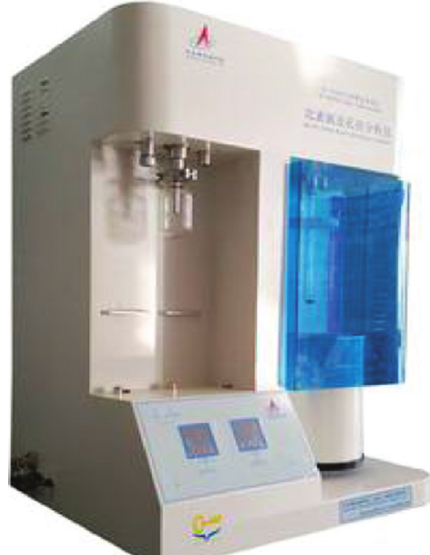
Figure 3: Specific surface area and pore size analyzer.